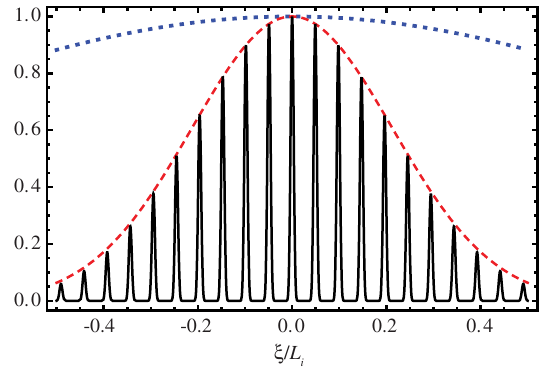
FIG. 2. Solid black curve is the normalized ionization rate for a laser field having a Gaussian envelope with the para- ¼ 64 and Δ ¼ 0 . 2 . The rms width of each peak is L meters k i i σ ¼ σ ≃ Δ =k . Dashed red curve shows the longitudinal ξ ψ =k i i region of ionization due to the laser envelope, with rms width σ ¼ L Δ . Dotted blue line is the normalized laser field envelope ξ i with rms length σ ξ ¼ L i